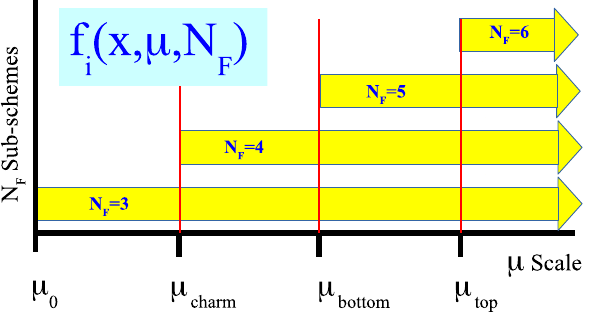
Fig. 11 An illustration of the separate N F renormalization sub- schemes which define the VFNS. In contrast to Fig. 1a, each of the N F sub-schemes are available for all scales above μ m . The particular scheme can be specified by choosing N F when calling the PDF, i.e. f i ( x ,μ, N F ) . This illustration shows a matching scale of μ m = m